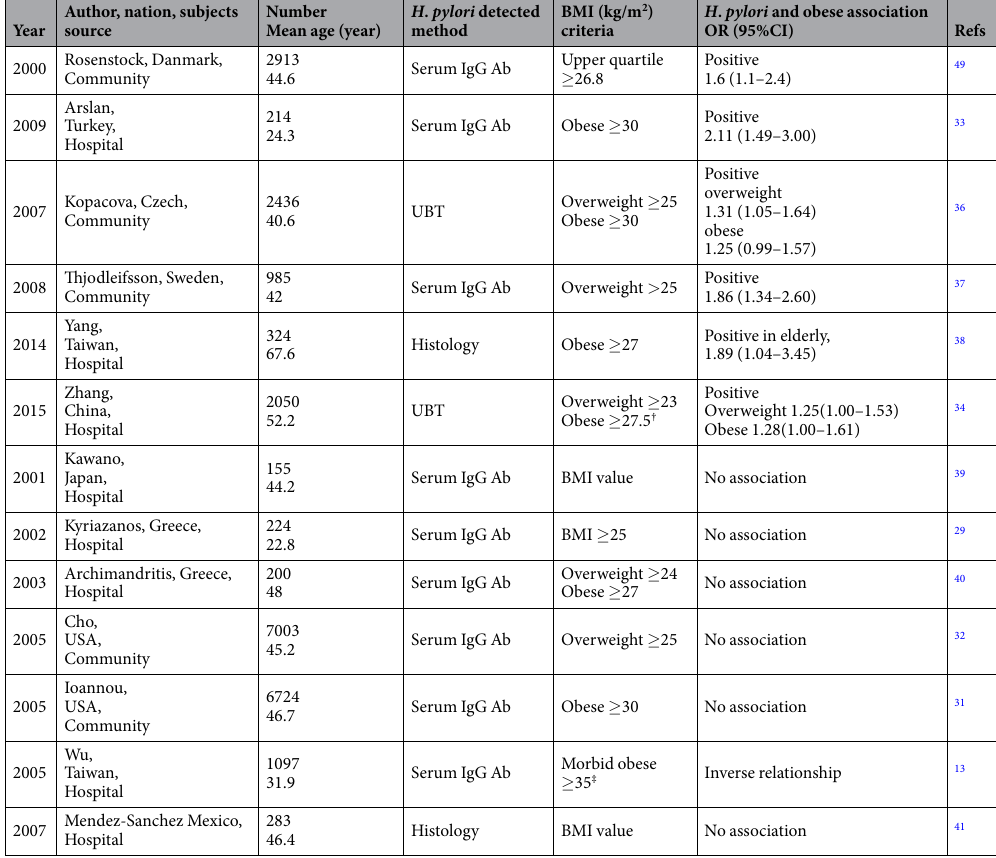
Table 4. Recent studies of the association between H . pylor i infection and overweight/obese. † Use China BMI criteria for obese ( ≥ 28) OR = 1.14 (0.89–1.47) (P > 0.05) ‡ morbid obesity (BMI ≥ 35) vs. normal weight (BMI <